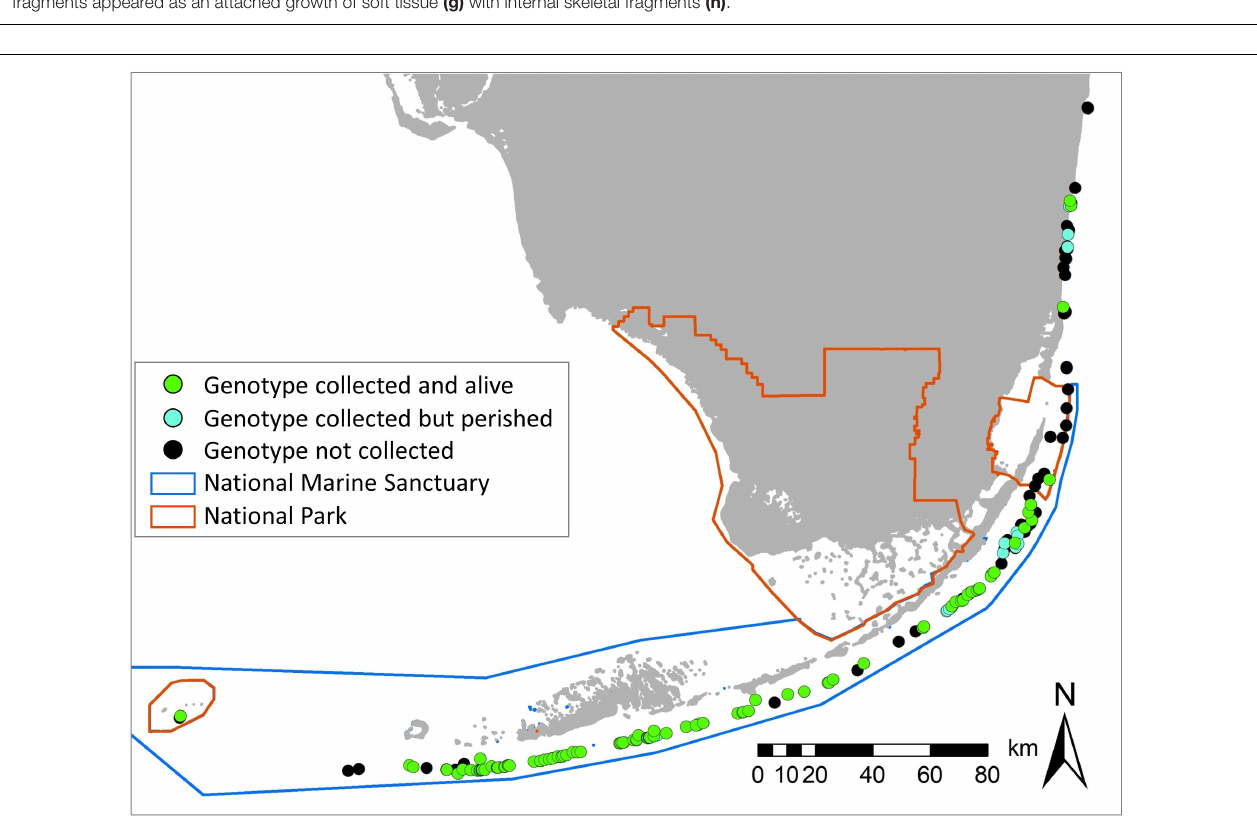
FIGURE 2 | Location of all known Dendrogyra cylindrus colonies on the Florida Reef Tract (black), overlaid with the genotypes collected. Most collected genotypes have survived and are held in rescue facilities (green); a few were collected but perished